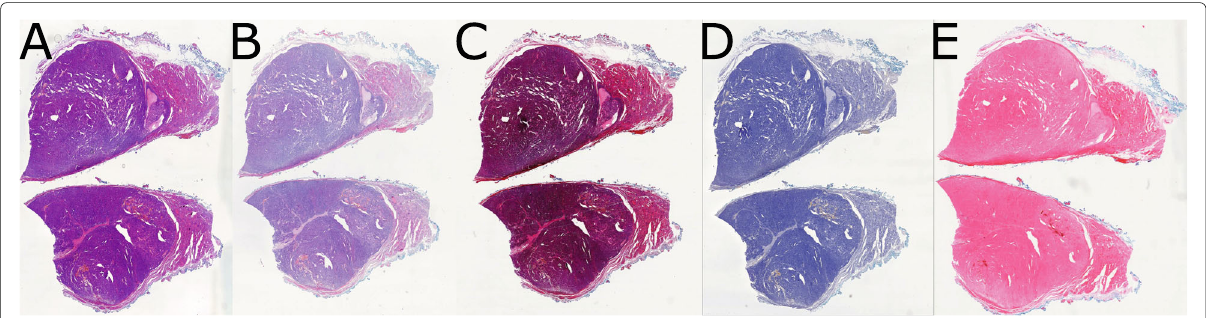
Fig. 2 Exemplary miniature image of the WSI that forms the HEV data set. Serial tissue sections from a thyroid tissue with a follicular carcinoma with HE-staining. For every slide the staining protocol is intentionally modified: A ) Standard protocol at the Institute of Pathology, Medical Faculty Mannheim, Heidelberg University ( HE ) B ) Shortened staining time ( shortHE ) C ) Prolonged staining time ( longHE ) D ) Only hematoxylin-stain ( onlyH ) E ) Only eosin-stain ( onlyE